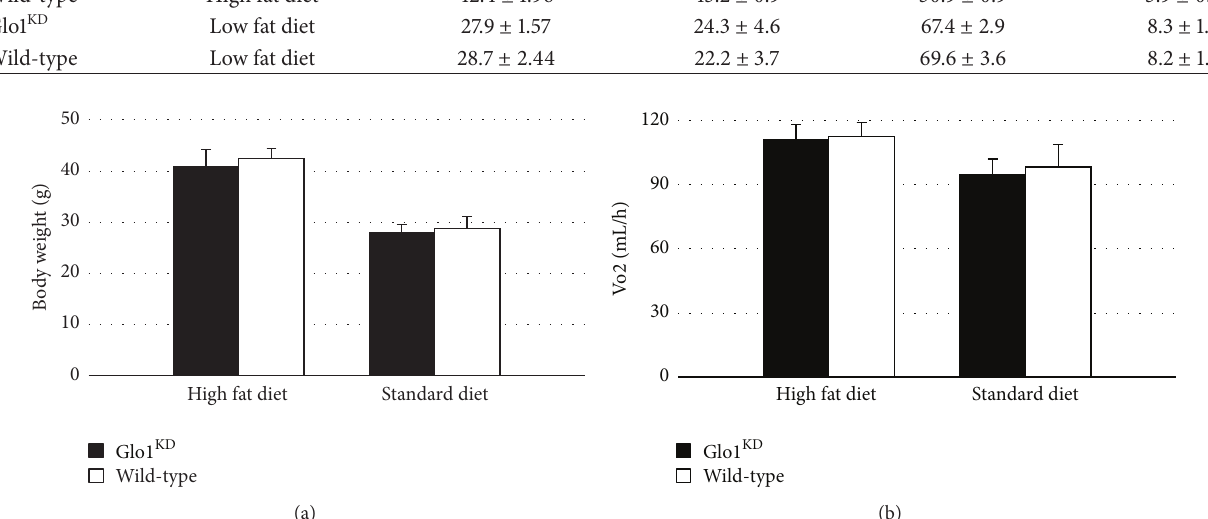
Figure 2: (a) The mean body weight did not differ between Glo1 KD mice and wild-type mice, neither on high fat diet ( 𝑝 = 0.654 ) nor on standard diet. (b) The mean oxygen consumption over 24h was measured using the PhenoMaster system. The genotype did not have a significant influence ( 𝑝 ≥ 0.05 ).